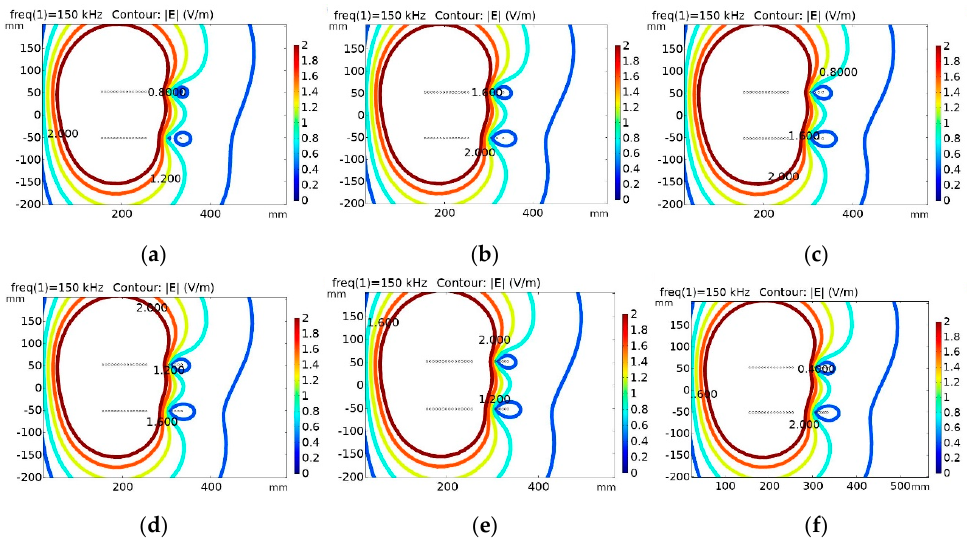
Figure 9. The power transmission efficiency η and EMF distribution which are from the WPT system with inductive shielding coils change with the turn of shielding coils ( N s ): ( a ) N p = 15, N s = 2, η = 94.18% and M eq = 28.62 μ H; ( b ) N p = 15, N s = 3, η = 94.27% and M eq = 28.58 μ H; ( c ) N p = 15, N s = 4, η = 94.30% and M eq = 28.61 μ H; ( d ) N p = 15, N s = 5, η = 94.28% and M eq = 28.60 μ H; ( e ) N p = 15, N s = 6, η = 94.19% and M eq = 28.60 μ H; ( f ) N p = 15, N s = 7, η = 93.95% and M eq = 28.57 μ H.